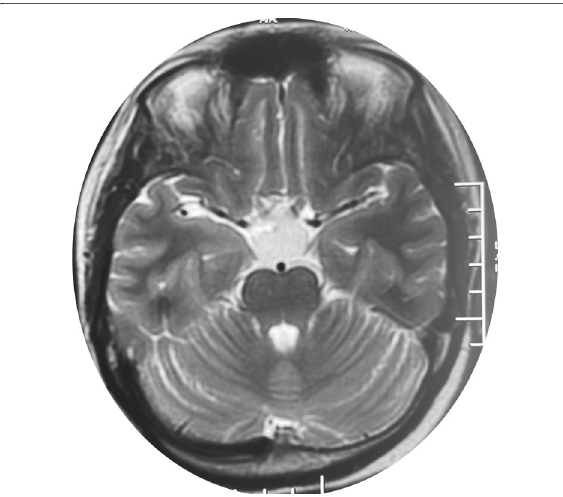
Fig. 1 CT scan of the brain showing hyperdense lesion in the suprasellar area